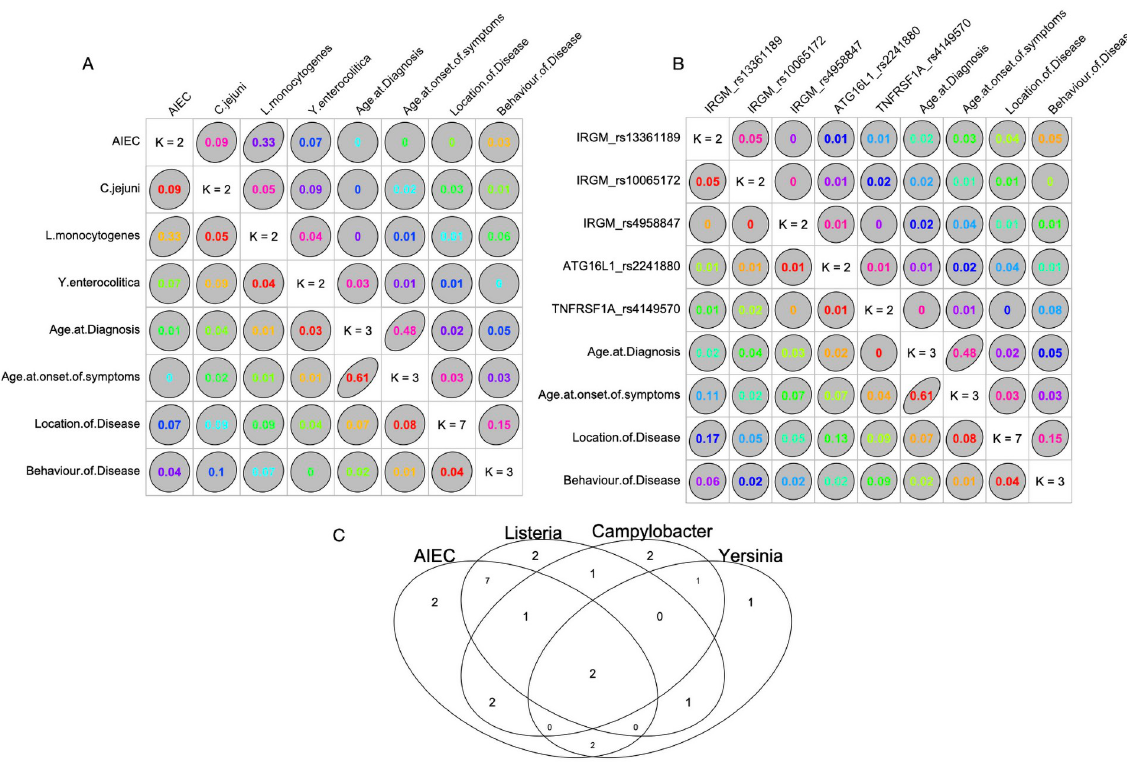
Fig 2. Measurement of association and co-occurrence of the prevalence of pathobionts and risk alleles with the clinical features in patients with CD. A) Association measurement between and amongst pathobiont prevalence (noted as ‘Positive’ and ‘Negative’ for each pathobiont type) and the clinical features of the patients with CD using Goodman and Kruskal’s Tau association; B) Association measurement between the risk allele prevalence (noted as ‘presence’ and ‘absence’ for risk allele for each gene type) and amongst and the clinical features of the patients with CD using Goodman and Kruskal’s Tau association; C) Venn Diagram depicting the co-occurrence of pathobionts in patients with